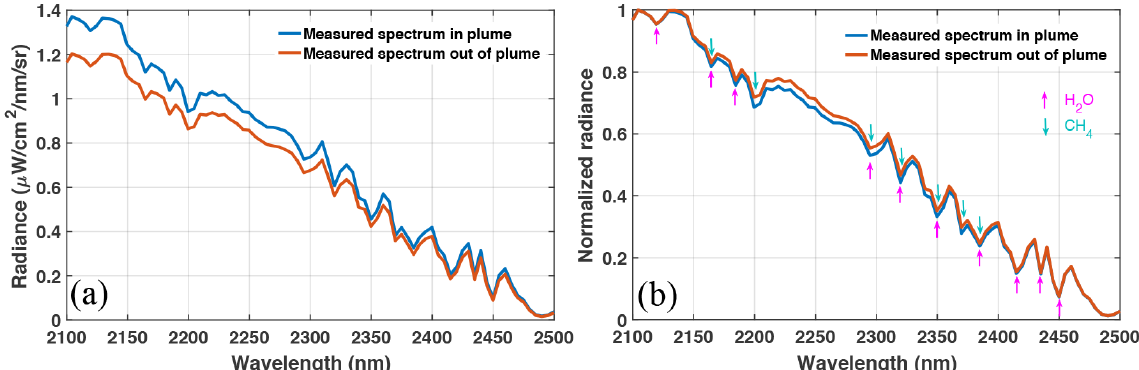
Figure 3. (a) Real radiance and (b) normalized radiance at cross-track detector elements (in and out of plume) from the sample AVIRIS-NG measurement. The colored arrows in (b) show the main absorption features due to H 2 O (purple) and CH 4 (green).